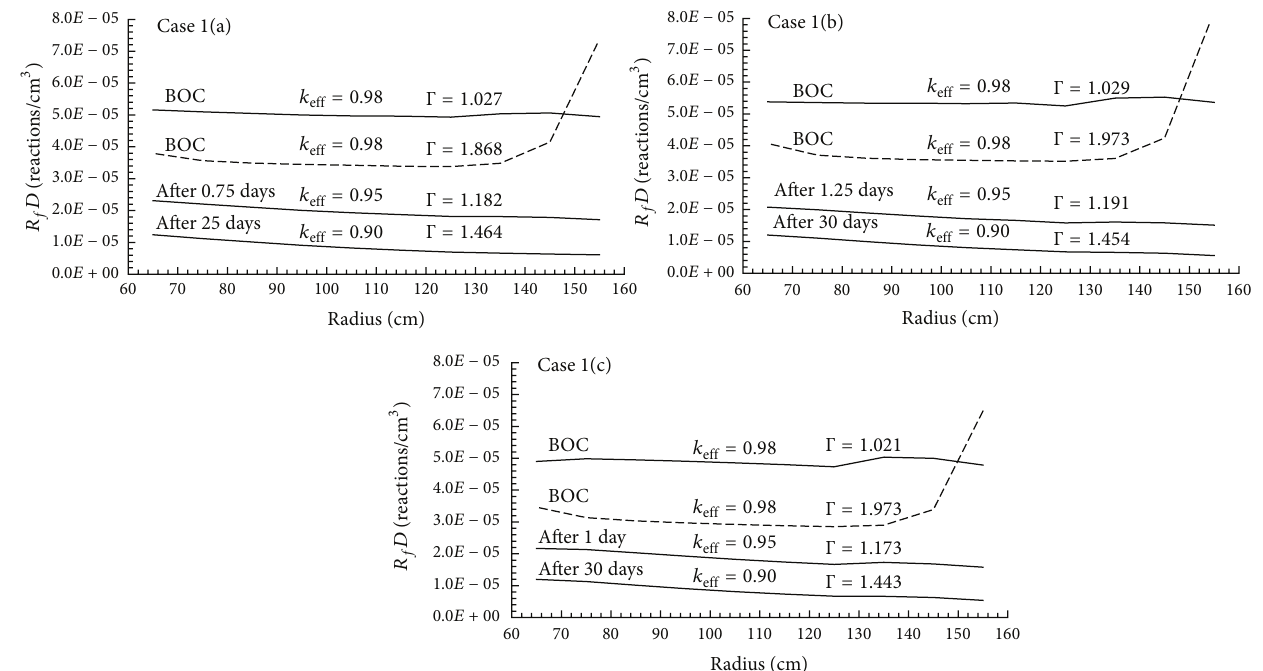
Figure 7: Variations of fission densities in the fuel core at the beginning and at the end of the cycle versus the core radius (solid lines indicate the flattened power case).